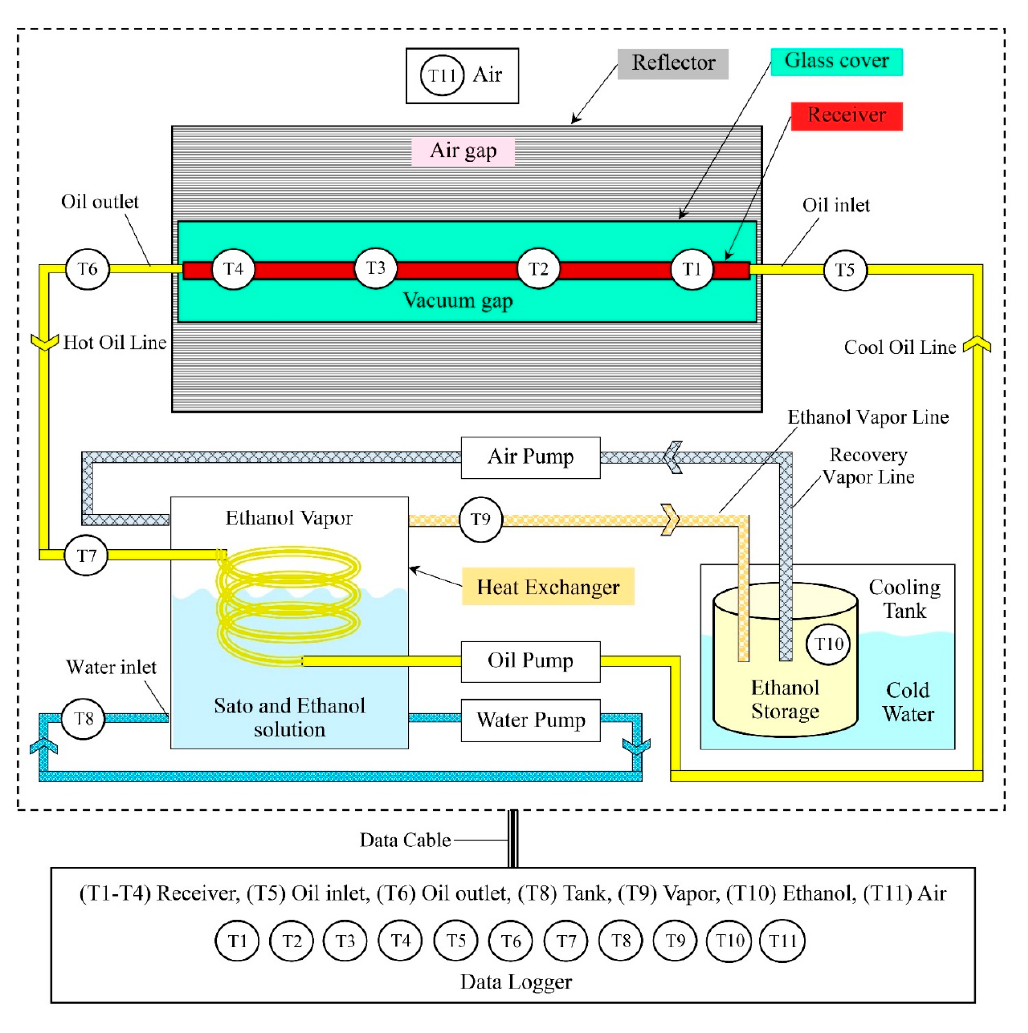
Figure 2. Schematic diagram of the vacuum-tube parabolic solar collector system in semi-automatic controlled ethanol distillation (drawn not to